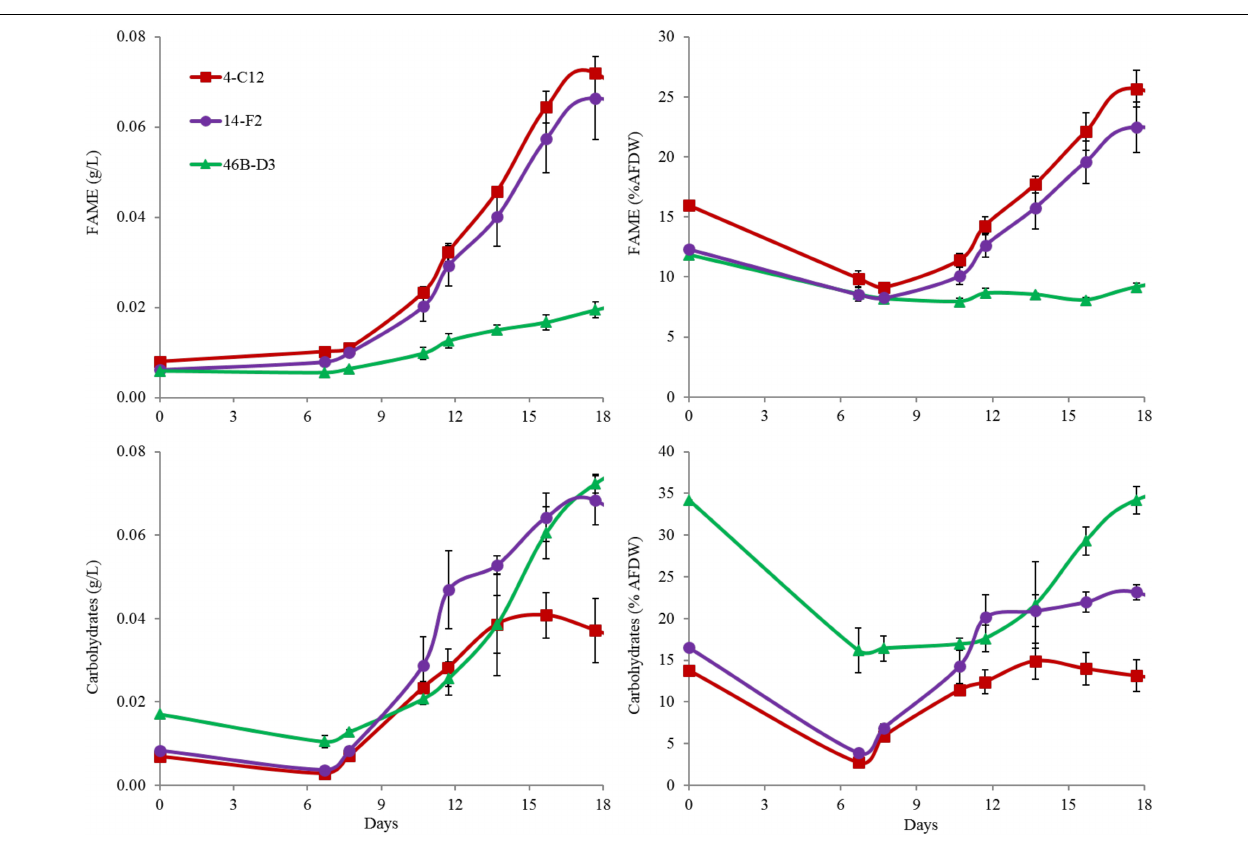
FIGURE 2 | FAME and Carbohydrate analysis of strains grown outdoors during the winter month of February 2016 (1st–19th). Average and standard deviation error bars are from 3 biological